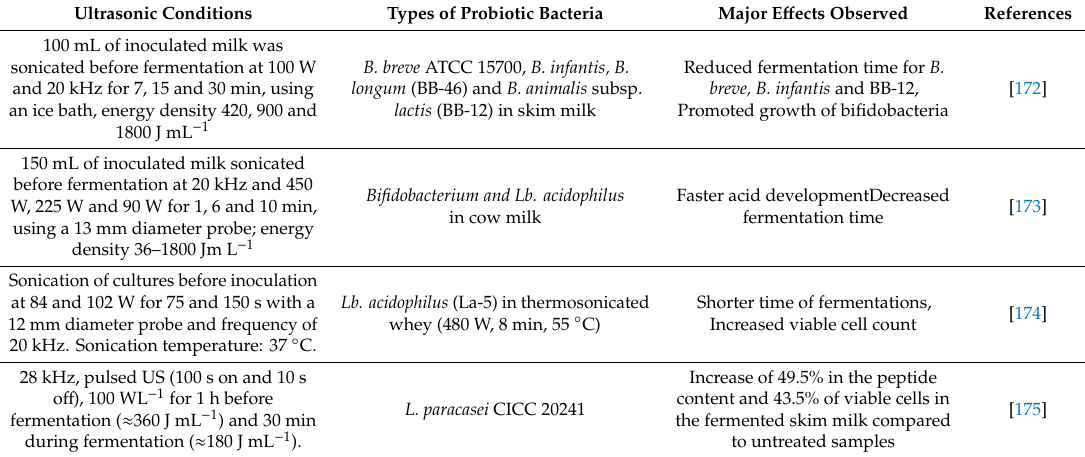
Table 6. Major e ff ects of employing ultrasound into probiotic